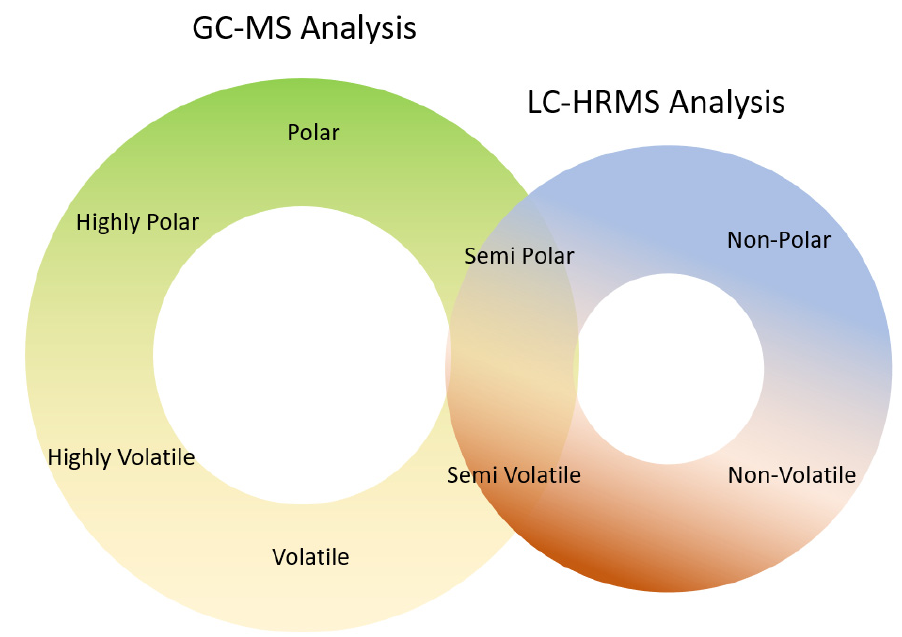
Figure 1. Technical Coverage of Constituent Properties in JUUL Aerosol Chemical